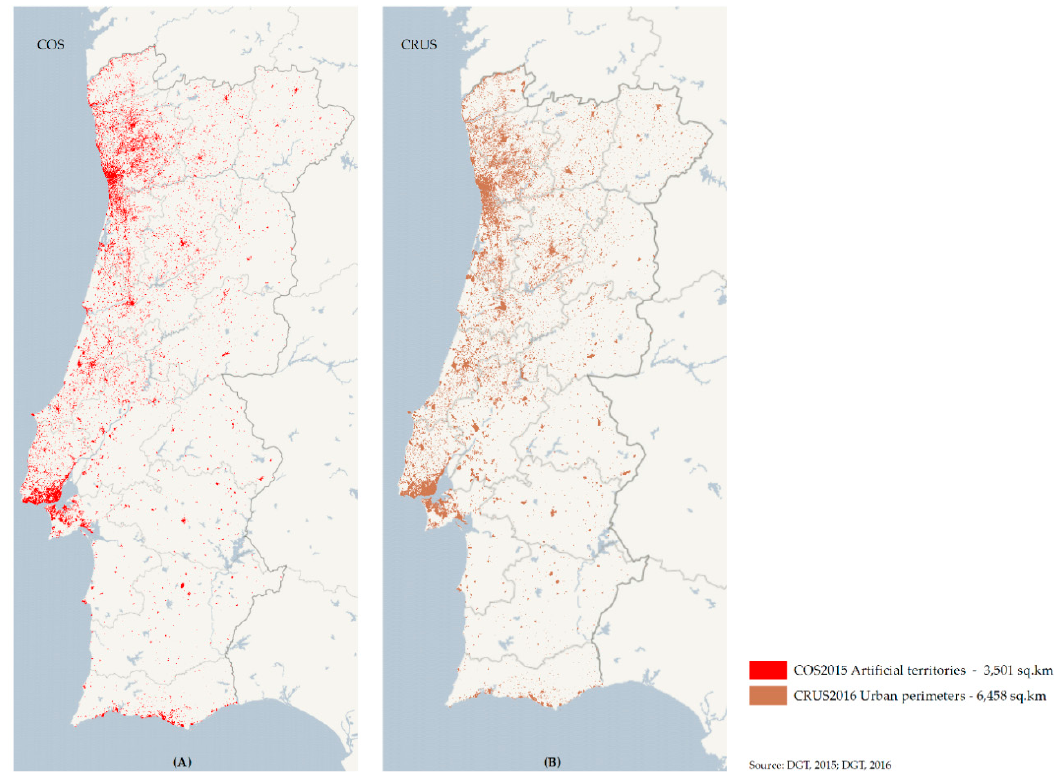
Figure 4. Artificial territories and urban perimeters according to land use and land use regime maps ( A ) COS 2015; ( B ) CRUS 2016.